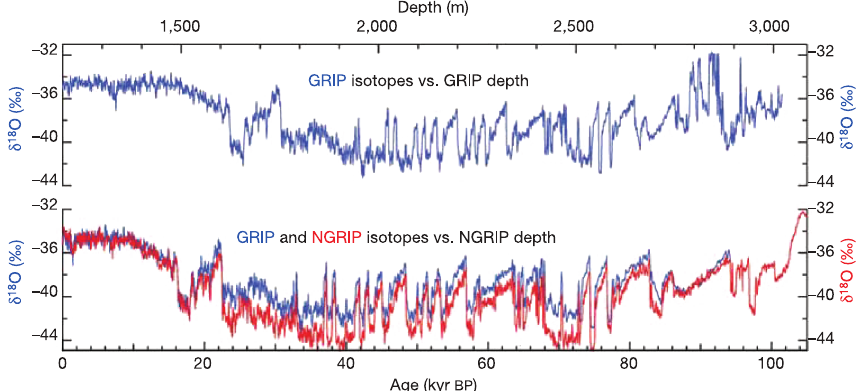
Fig. 7. The GRIP ( a , blue) and NGRIP ( b , red) oxygen isotopic profiles with respect to depth. For comparison, the GRIP record (blue) has been plotted on the NGRIP depth scale using the rapid transitions as tie points (adapted from North GReenland Ice core Project members,